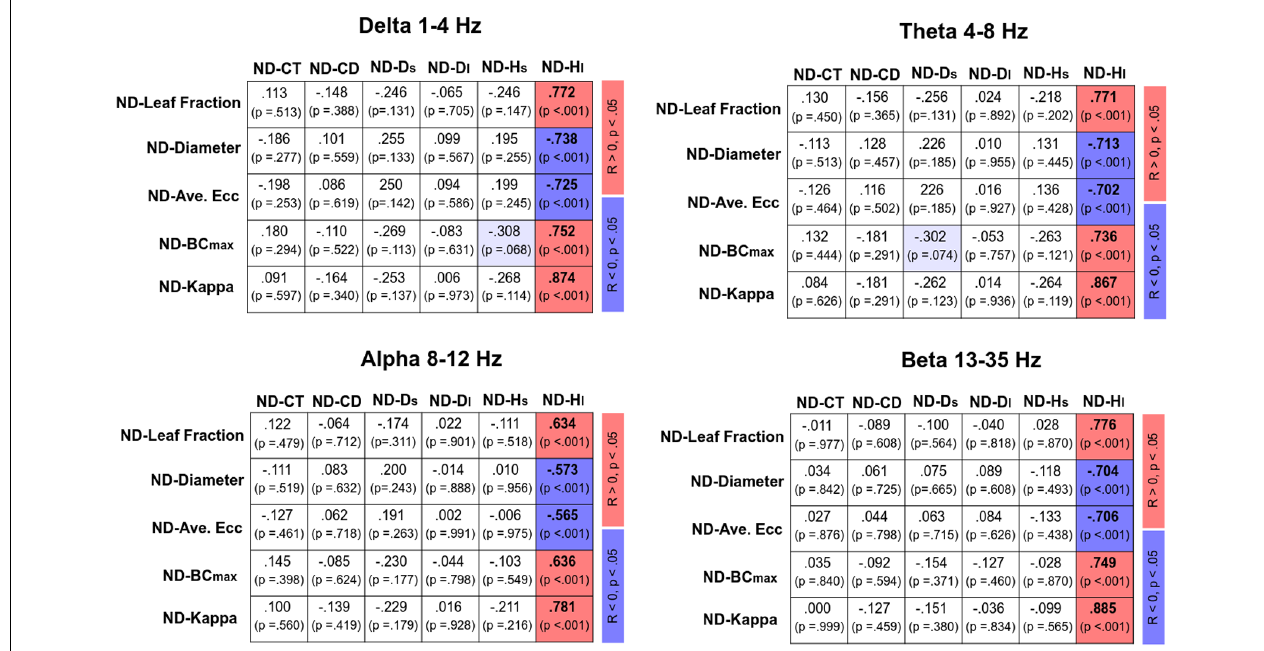
FIGURE 5 | Correlation matrix of normalized difference in sub-band MST and normalized difference in SDA variables [normalized difference (ND): (EO − EC)/EC]. Red and blue shaded areas represent significant positive and negative correlations ( p < 0.05) of the normalized difference in sub-band MST and normalized difference in SDA variables, respectively. Light shaded areas represent marginally significant correlation of the sub-band MST and SDA variables ( p < 0.10).